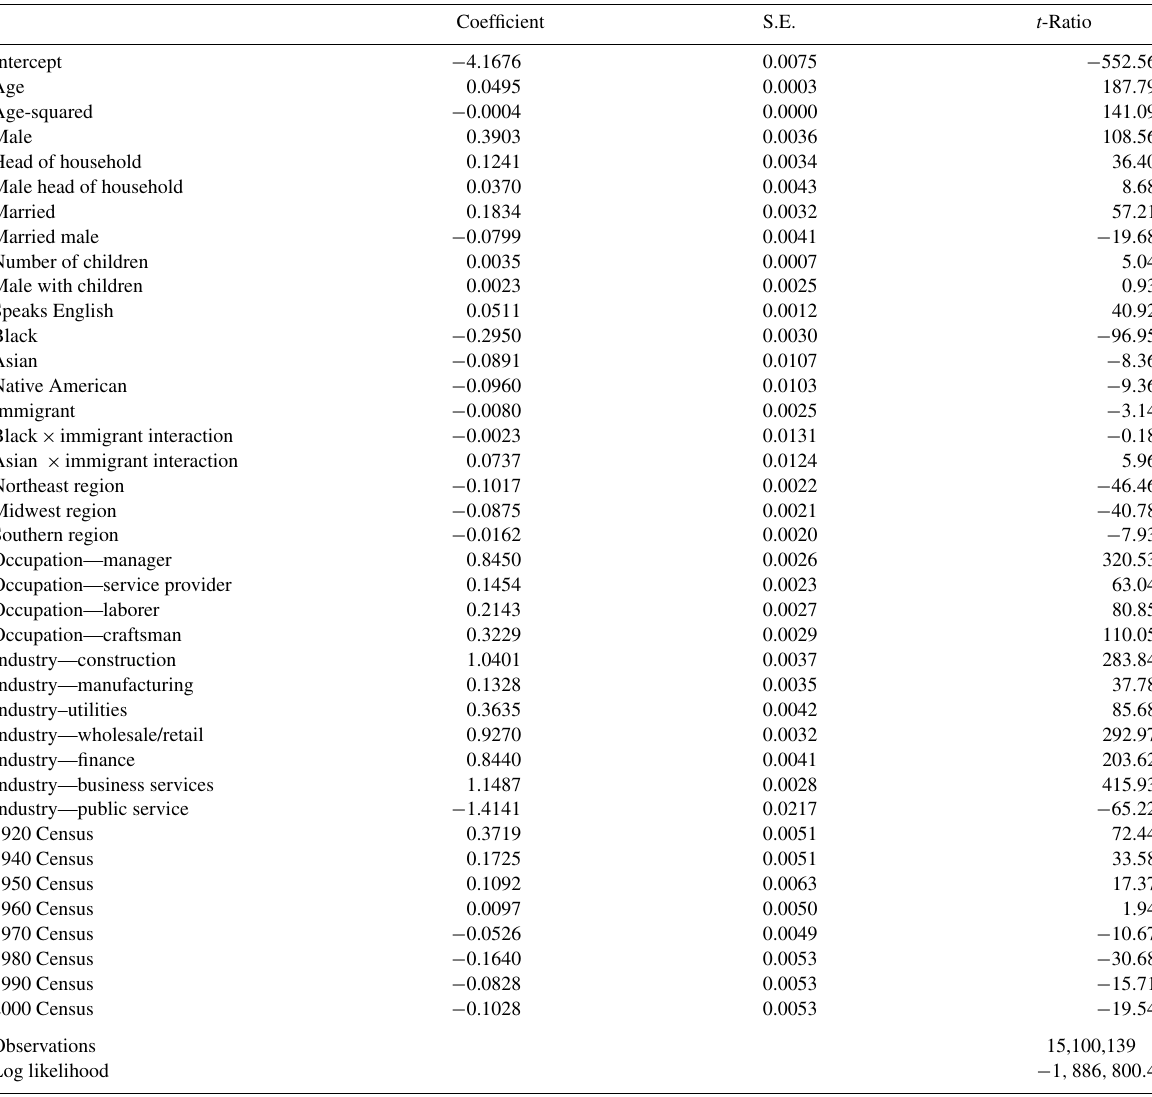
Table 8 Coefficients from the probit self-employment equation: